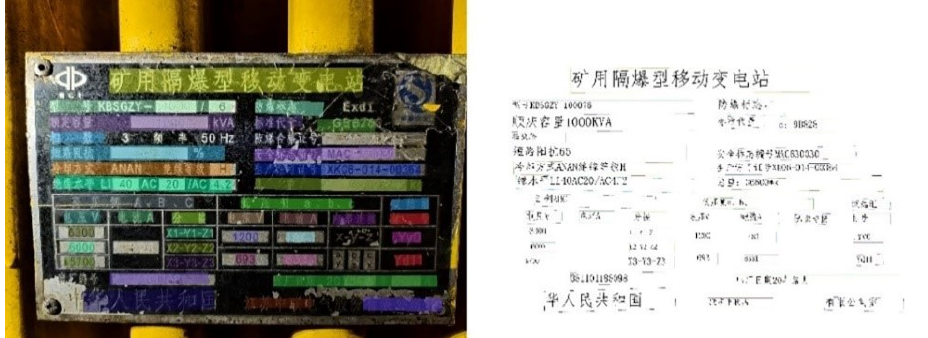
Figure 3. Text instances of nameplates and labels are depicted in this image, which represents a typical example from our industrial nameplate dataset. The instances of text are particularly challenging to predict due to their complexity, which is characterized by variations in color, shape, background, and density with special distributions. These challenging aspects of the dataset require advanced text detection and recognition techniques to achieve accurate